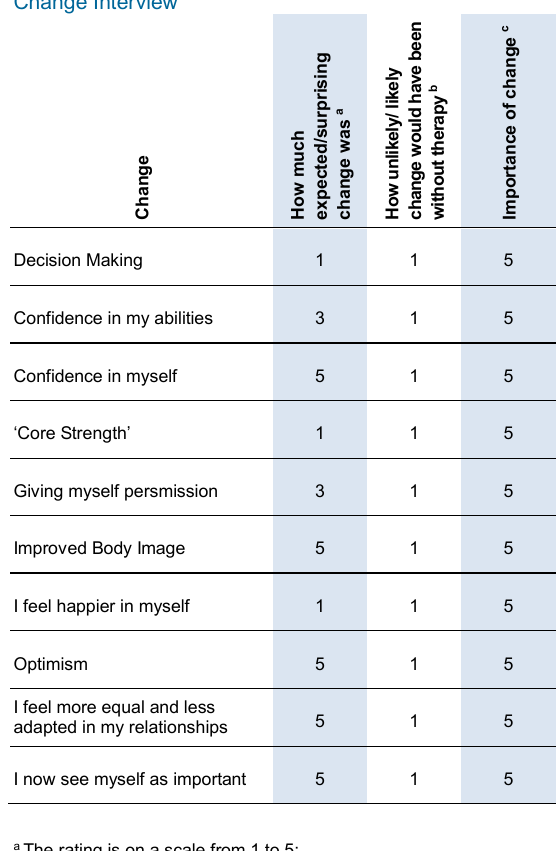
Table 2: Denise’s changes as identified in post-therapy Change